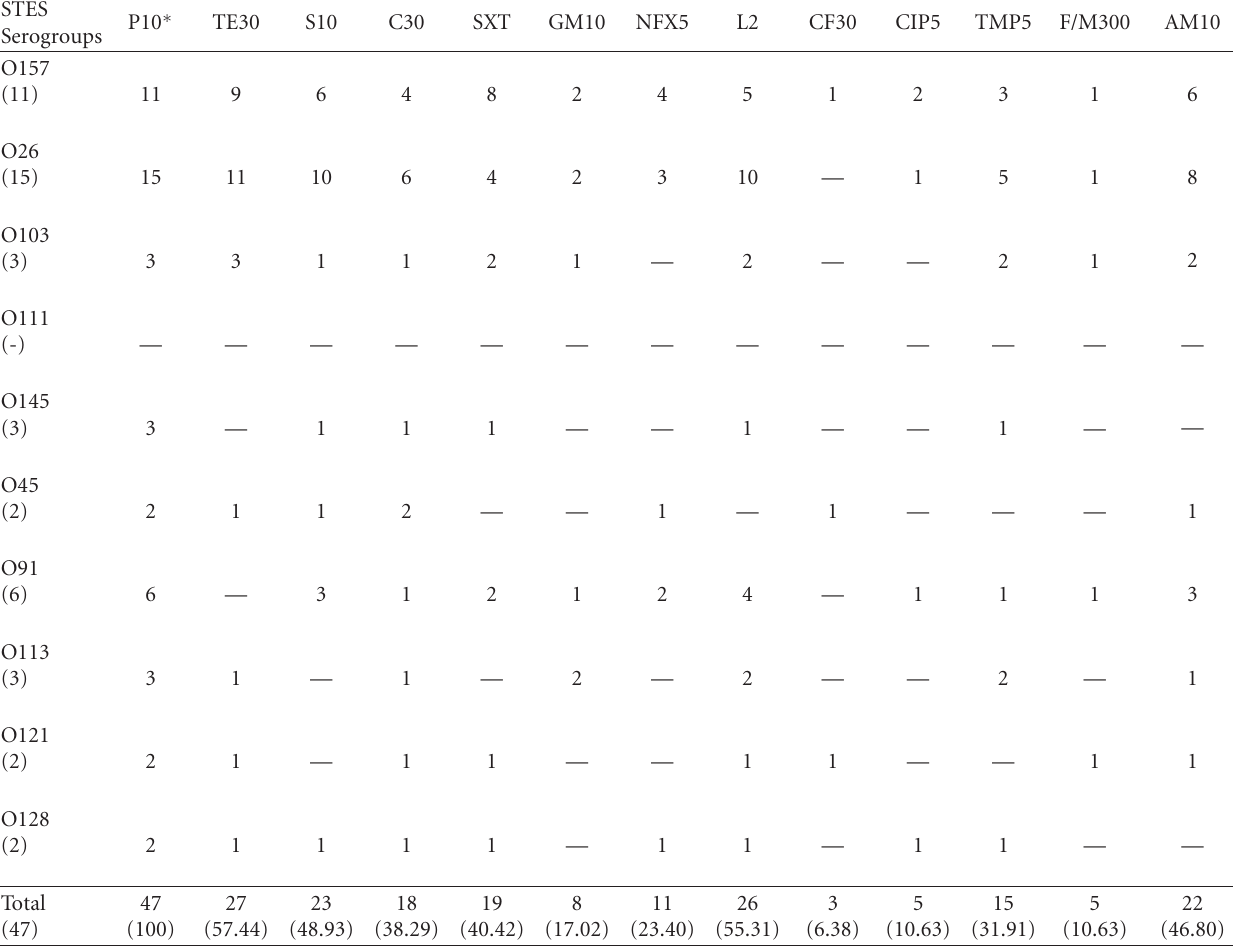
Table 9: Antibiotic resistance properties in STEC serogroups isolated from bovine mastitis (disk di ff usion method). STES